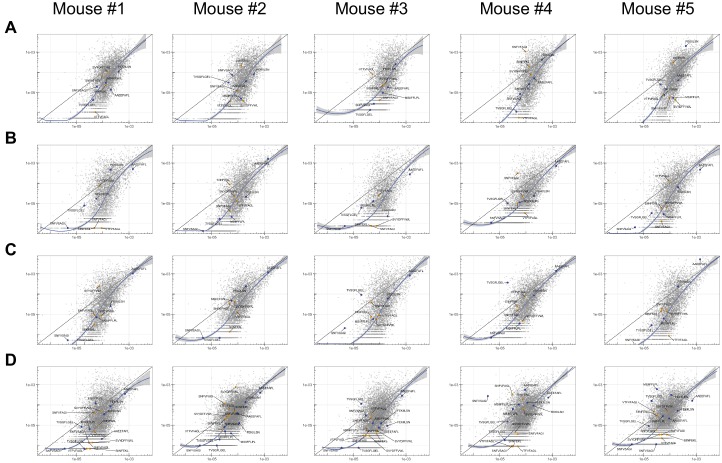
The abundance of each minigene in each mouse tumor after 17 days of growth in vivo (y-axis) compared to the abundance of each minigene in culture (x-axis) before injection across four groups of tumors: (A) wild type, (B) mutated, (C) ‘padded’ mutated and (D) mixed wild type and mutated peptide libraries.The straight black lines indicate x = y. LOESS (local best fit) lines are plotted in blue.